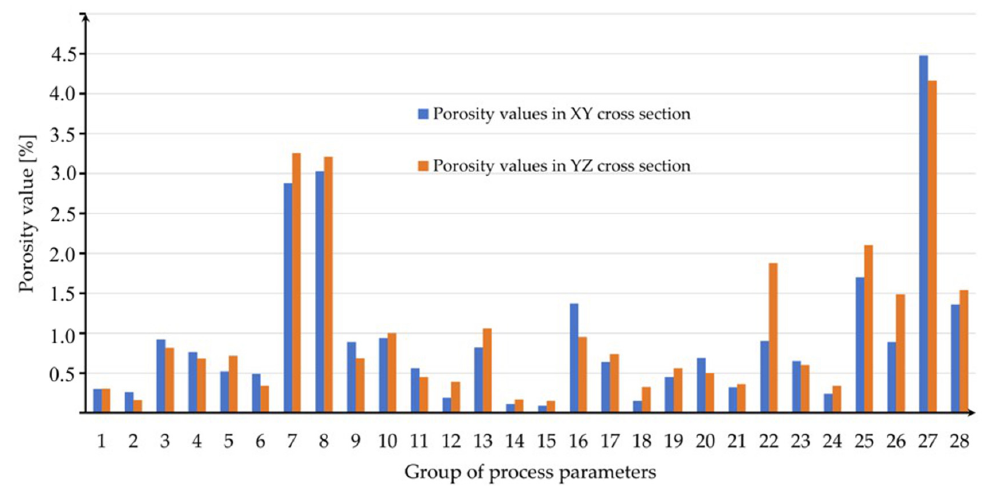
9 of 17 Figure 11. Evaluation of the porosity of a sample produced using 2 groups of parameters.